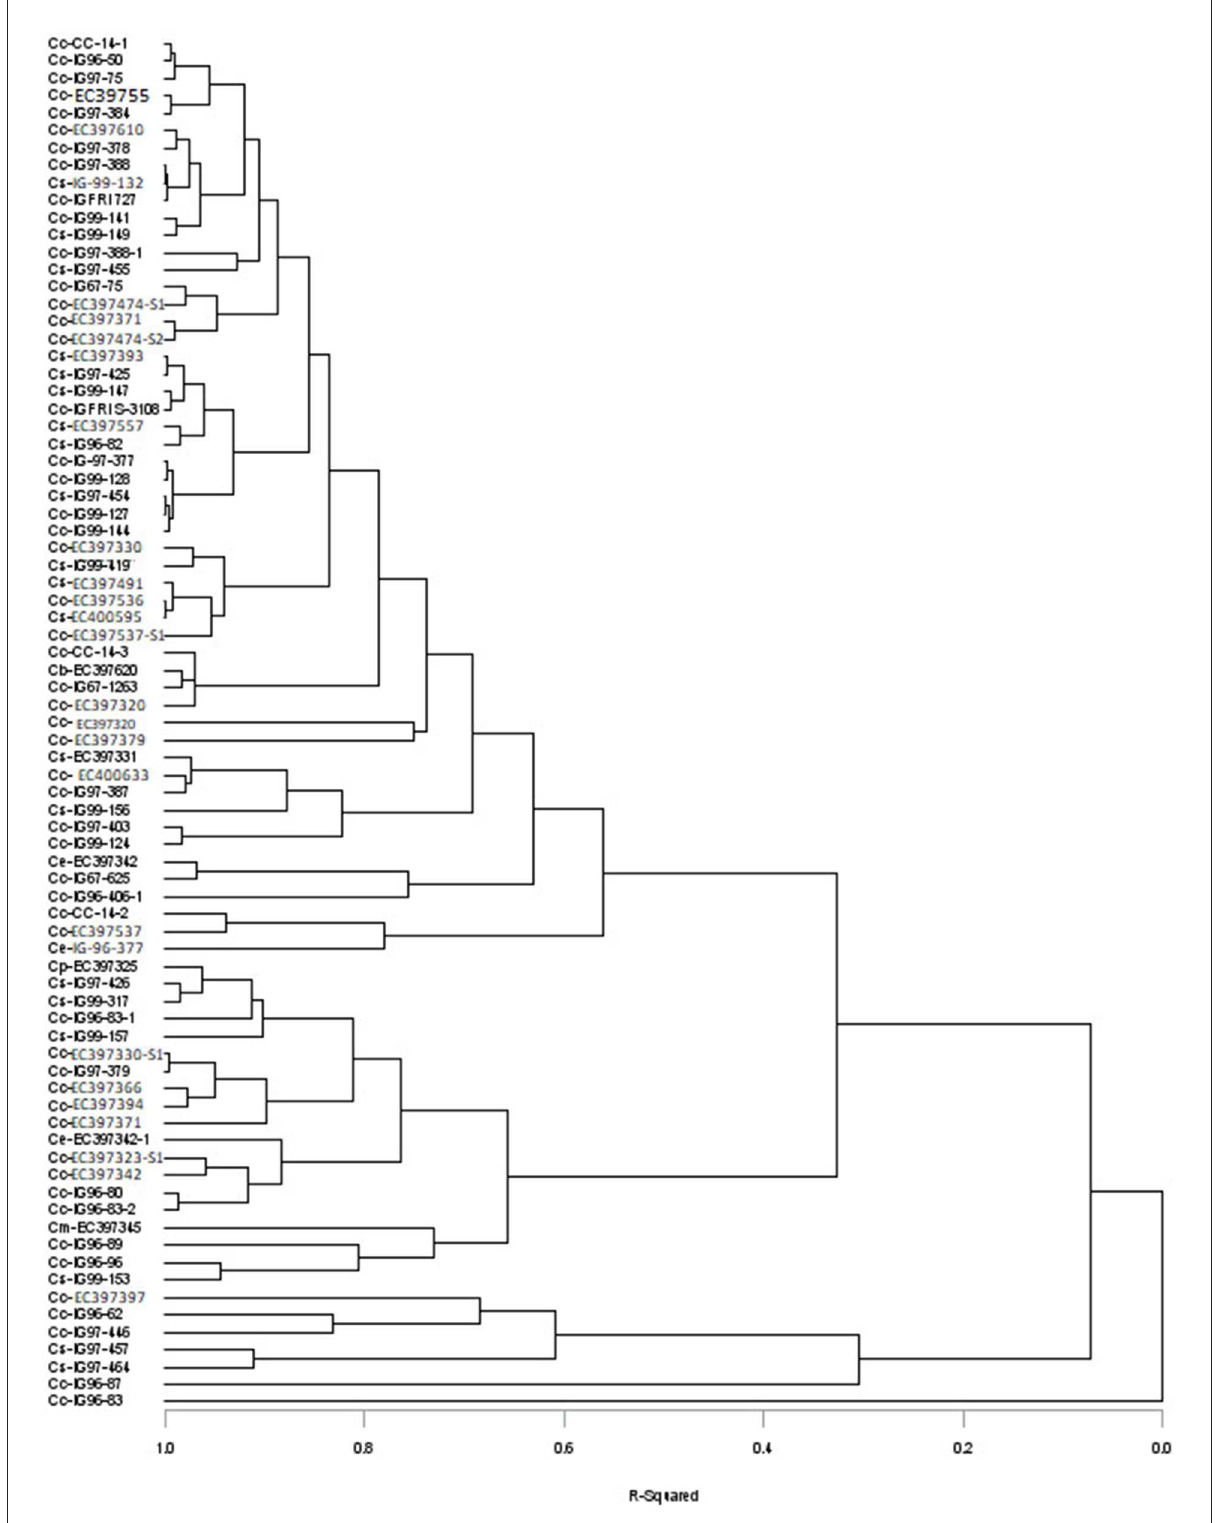
FIGURE1 Distribution of different Cenchrus species accessions into different clusters based on nutritional and biochemical traits (Cc, Cenchrus ciliaris ; Cs, Cenchrus setigerus ; Ce, Cenchrus echinatus ; Cm, Cenchrus myosuroides ; Cp, Cenchrus pennisetiformis ; Cb, Cenchrus biflorus ).